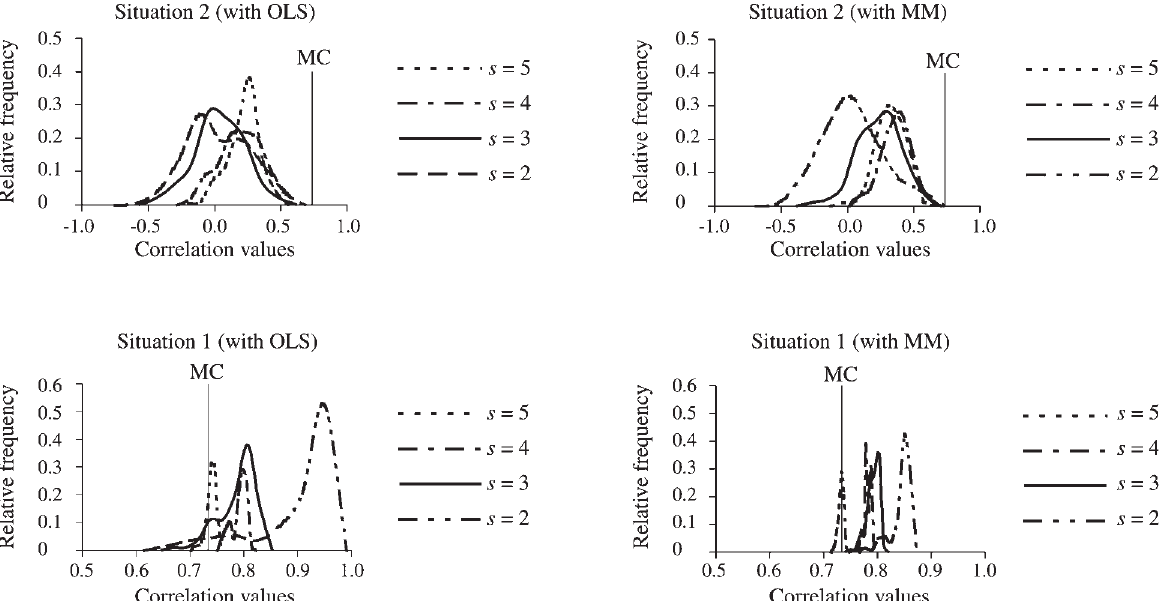
Figure 1 - Empiric distributions of the correlation coefficients between the predicted and observed hybrid means, considering the two following situa- tions: Situation 1: the observed hybrid means are included in the estimation of the genetic parameters and in the calculation of the correlation coefficient. Situation 2: the observed hybrid means were assigned to two different groups, where 75% of them were used to calculate the parameters, and the remain- ing 25% to estimate the correlation coefficient (MC is the maximum limit of the correlation coefficient, OLS is the ordinary least square estimation, and MM is the mixed model approach).